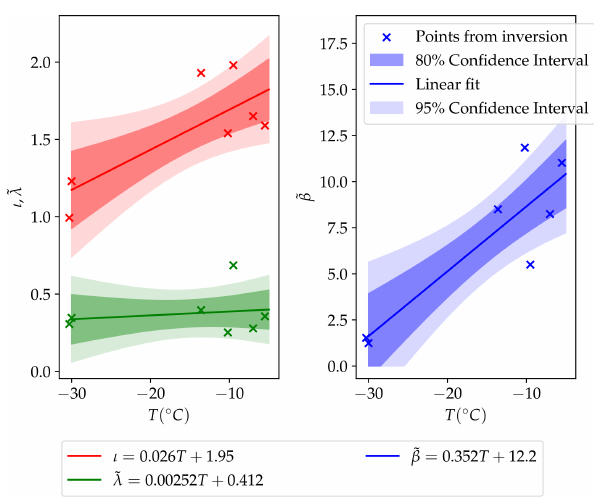
Figure 6. The model parameters ι, ˜ λ, ˜ β as functions of temperature, determined by linear regression to experimental data in both com- pression and simple shear, as conducted in Richards et al. (2021). The 95% and 80% confidence intervals are